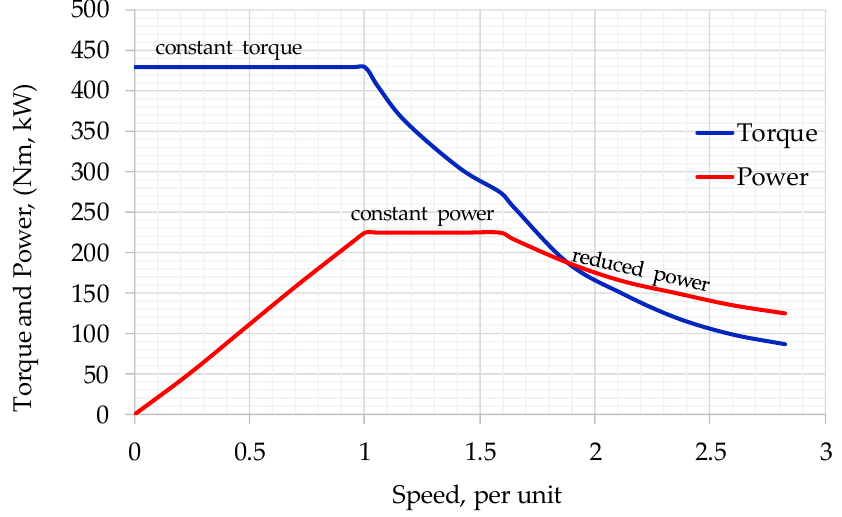
Figure 2. An example torque speed curve of the induction machine operating with a drive.